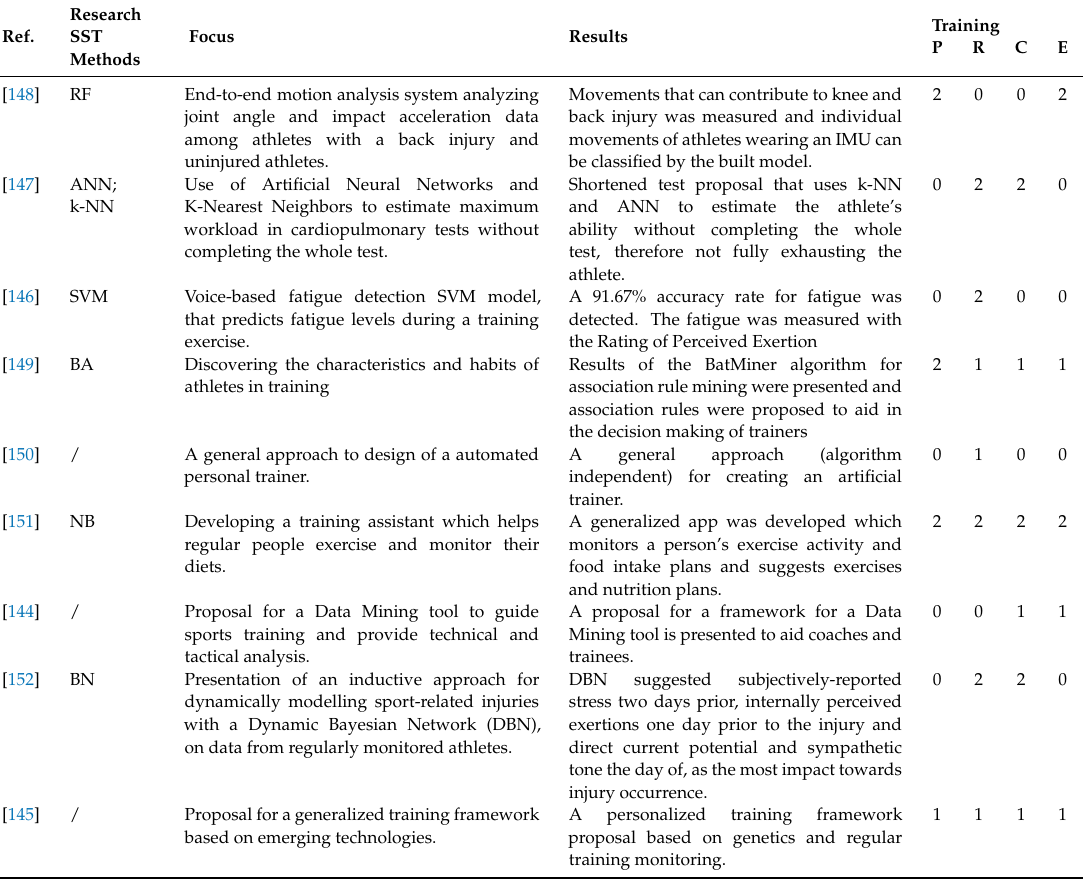
Table 19. Identified studies unrelated to any particular